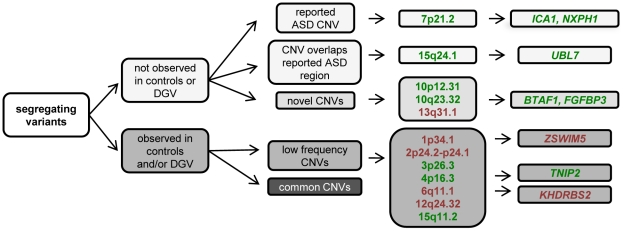
Prioritization of copy number variations of interest.Structural variants were first assessed to determine whether they were present in our control individuals or the Database of Genomic Variants. Literature searches were then performed to determine if the CNVs we identified were previously reported as ASD regions with similar breakpoints or overlay with larger ASD reported regions. Higher priority was given to variation absent in controls and those that fell within regions previously connected to ASDs. Low frequency CNVs were identified in our control HIHG and NBC dataset, but at a frequency below 1.5%. Duplications are in green and deletions are in red.